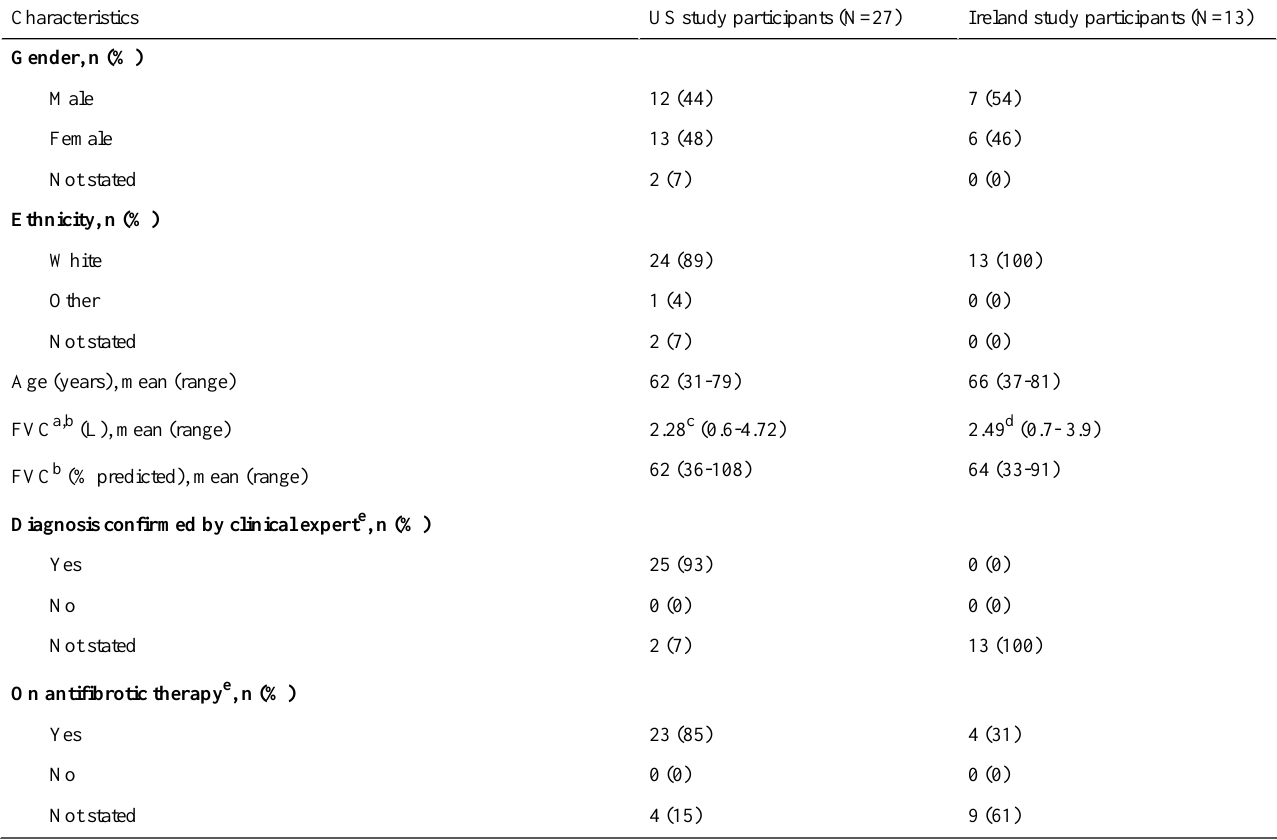
Table 1. Baseline demographic